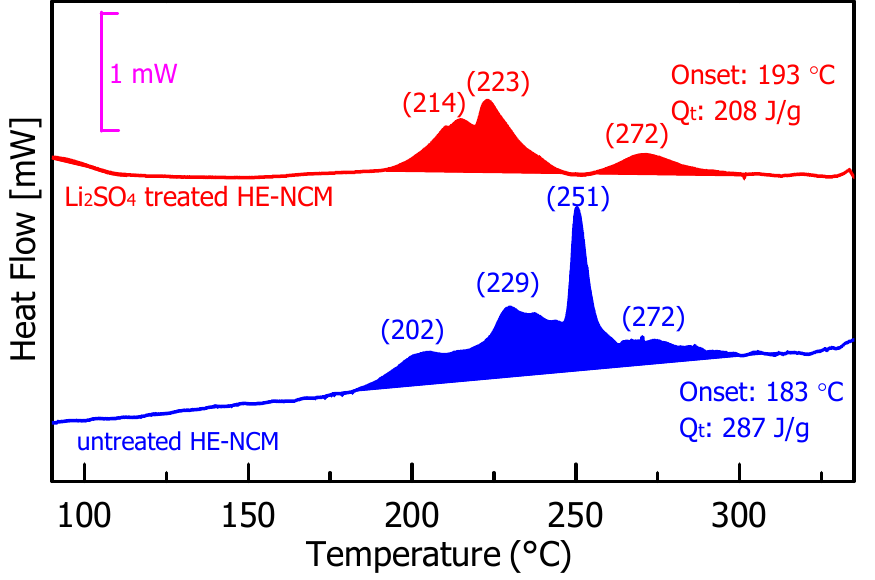
Figure 12. Results of the DSC measurements of untreated and Li 2 SO 4 -treated HE-NCM pristine materials (powders) in 1.0 M LiPF 6 /EC-EMC (3:7 v / v ) electrolyte solution (LP57).